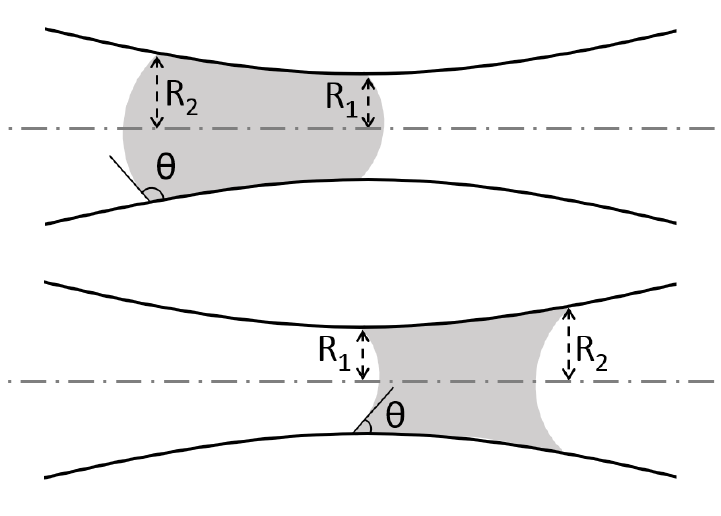
Figure 4. Condensate menisci radii, R 1 and R 2 , used to calculate ∆ P int